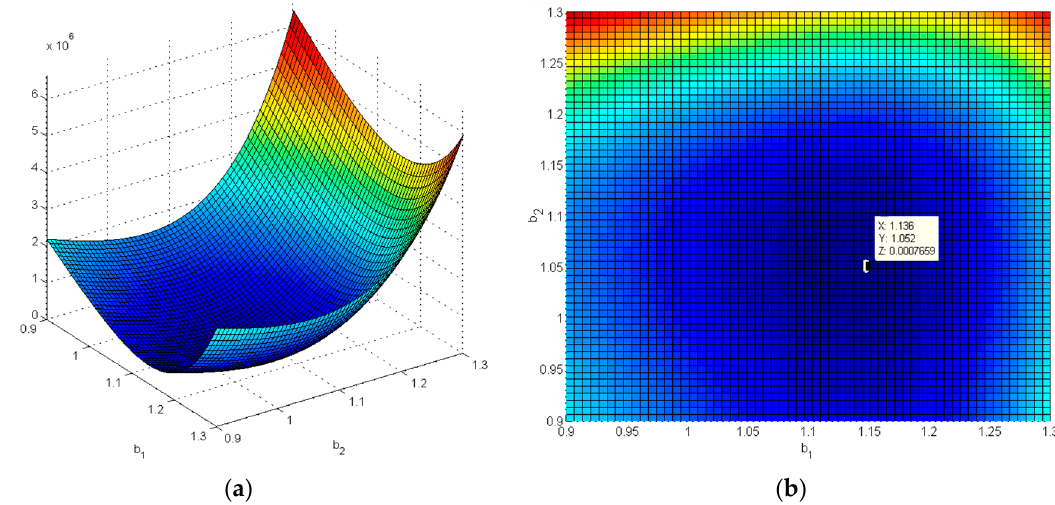
 and  ; ( b ) Minimum 1 2